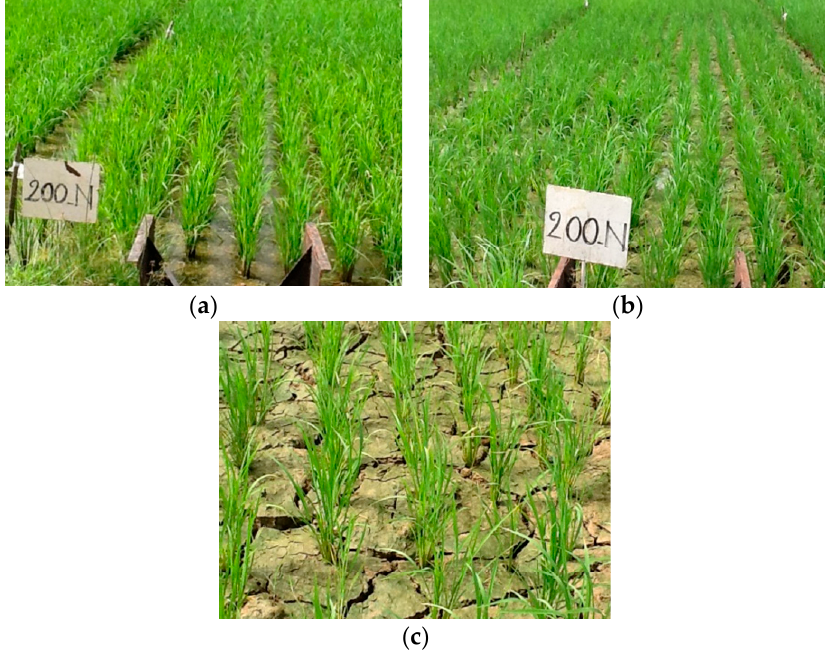
Figure 2. Crop canopy and soil status under 200 kg N ha − 1 under ( a ) continuous flooding, ( b ) AWD30, and ( c ) AWD60 during rice tillering stage.